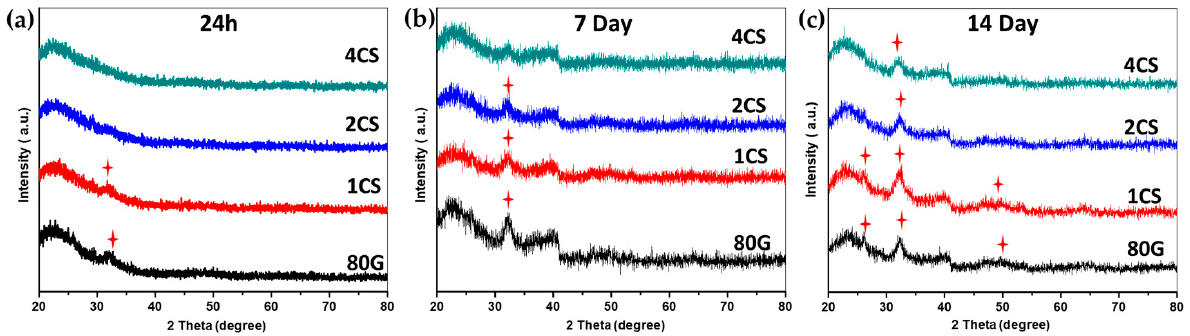
Figure 6. XRD patterns of SBF soaked MBG powders after ( a ) 24 h, ( b ) 7 days, and ( c ) 14 days; (red star marks indicate possible formation of a new hydroxyapatite (HAp) phase. star marks indicate possible formation of a new hydroxyapatite (HAp)